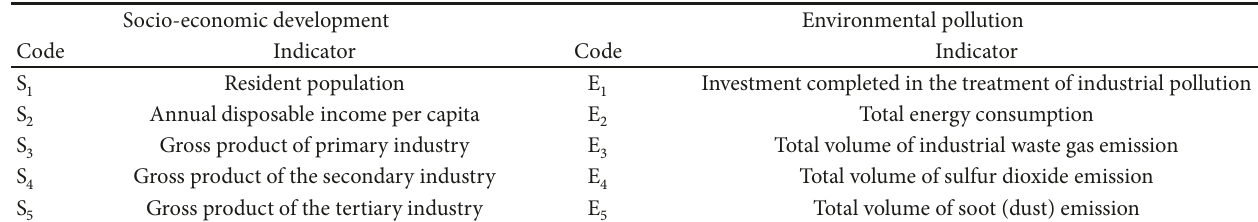
Table 1: Selected indicators and their corresponding